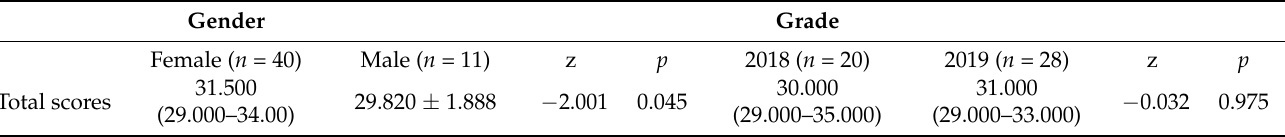
Table 2. Stratification analysis in the increased pressure group (based on the first questionnaire survey).